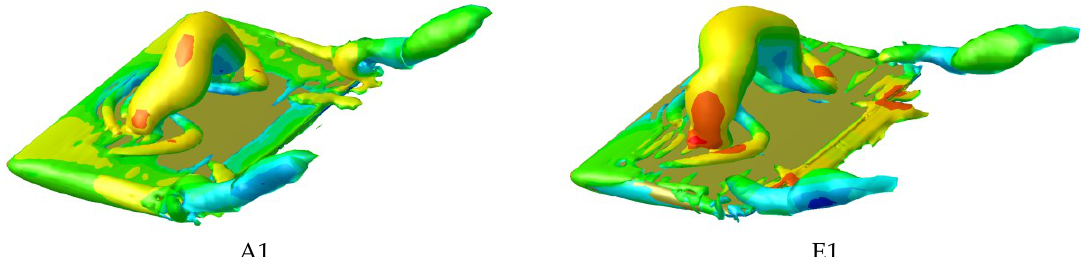
Figure 19. The time – history of pitch angle 𝜃 and AoA 𝛼 under five working conditions in Figure 18. ( a ) Time traces of the pitch angle and AoA of three working points A 1 , B 1 , and C 1 . ( b ) Time traces of the pitch angle and AoA of four working points A 1 , E 1 , C 1 , and D 1 .